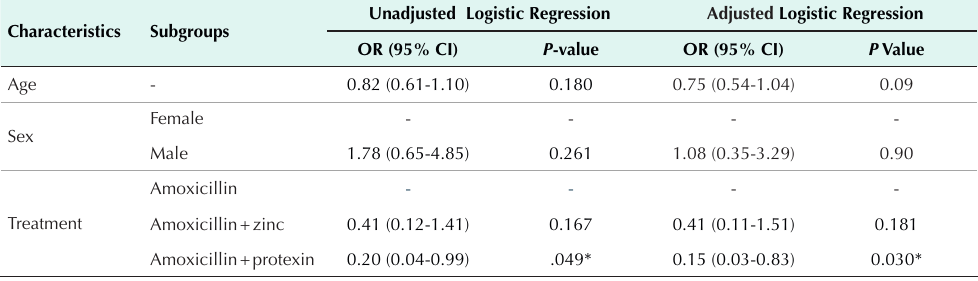
Table 2 . Results of Crude and Adjusted Logistic Regression Models for Factors Affecting Tympanometry in Children